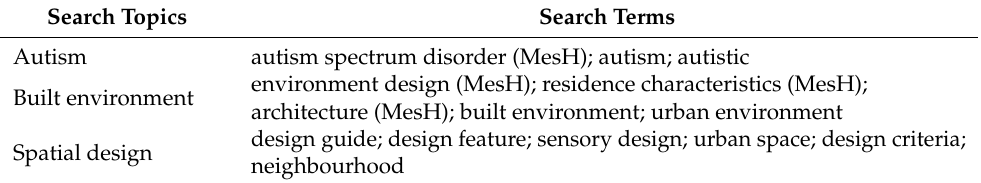
Table 1. Search settings.